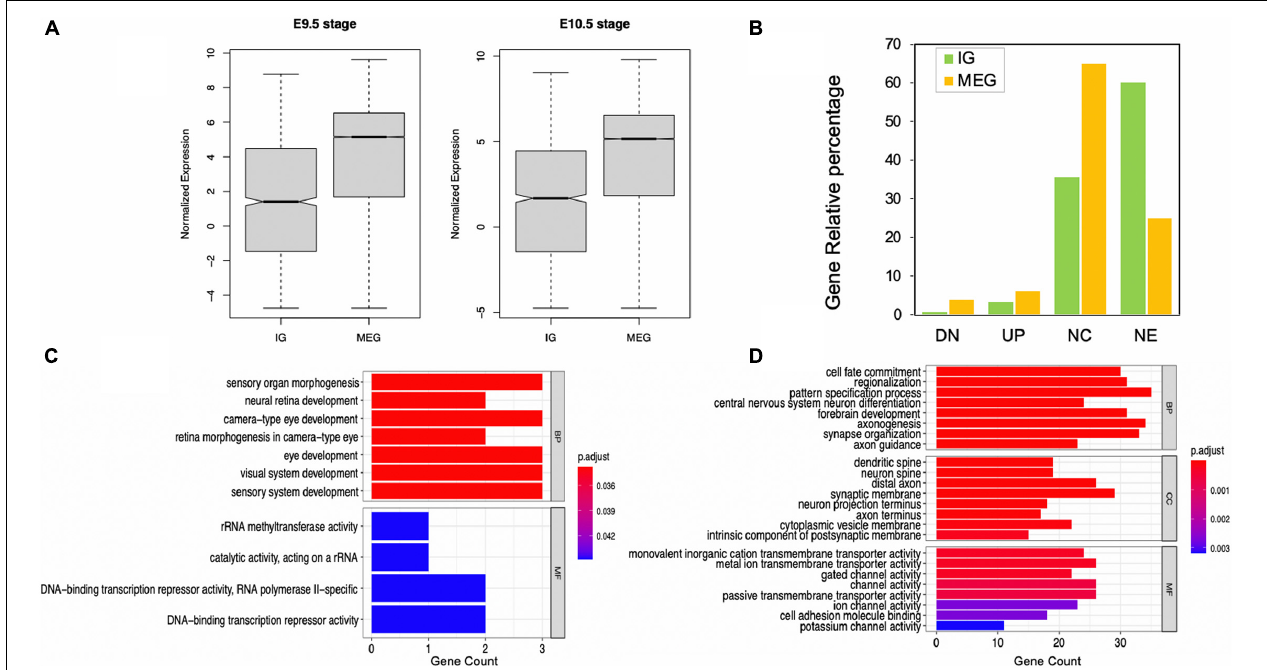
FIGURE 5 | Expression levels of IGs in mouse embryonic telencephalon compared to MEGs. (A) IG and MEG normalized expression at 9.5 and 10.5 embryonic stages; (B) IG and MEG, gene differential expression groups in 9.5 and 10.5 stages, (UP) upregulated, (DN) downregulated, (NC) no expression changes, (NE) not expressed. Enrichment of functions in upregulated IGs (C) and MEGs (D) . Each barplot shows significantly enriched gene ontology (GO) terms on the y-axis, colored by their p -adjusted values, while gene count is represented on the x-axis. Test gene sets for enrichment analysis were the up-regulated genes in each dataset, and the background set was all up-regulated genes. GO terms are grouped by BP (biological process), CC (cellular component), and MF (molecular